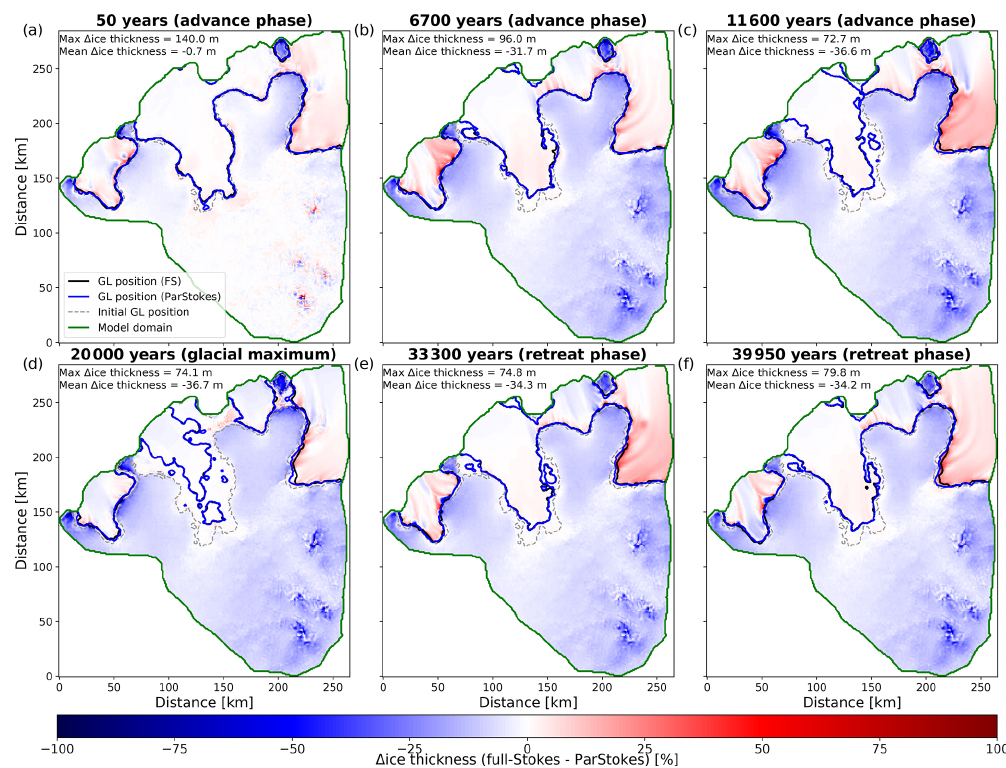
Figure 7. Differences in grounding-line position and ice thickness between the classic MUMPS and ParStokes solver setup for the soft-bed simulation at specific time